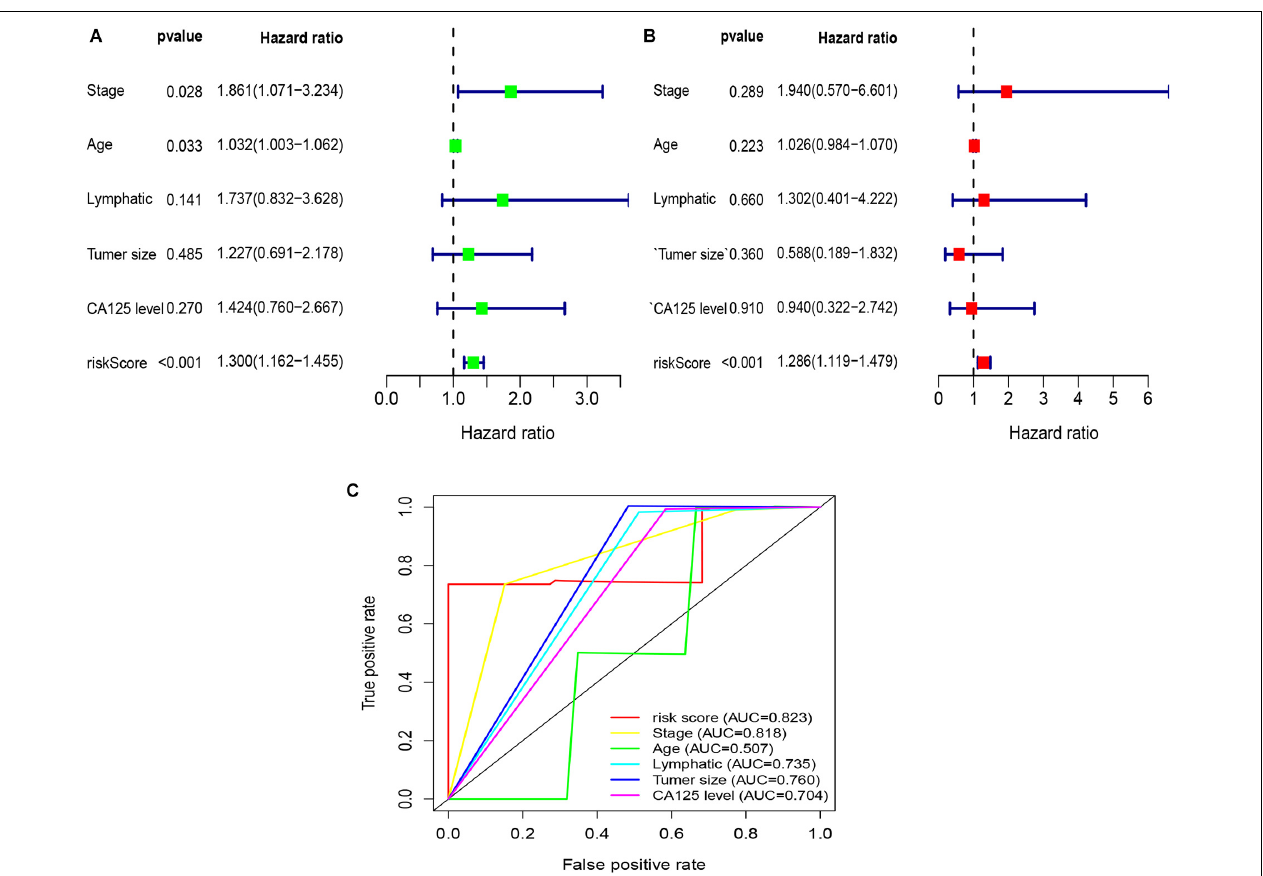
FIGURE 6 | Univariate and multivariate Cox regression analyses based on the risk score and other clinical features in our clinical specimens. (A) Univariate Cox regression analyses. (B) Multivariate Cox regression analyses. (C) ROC curve analysis of the risk score and other clinical